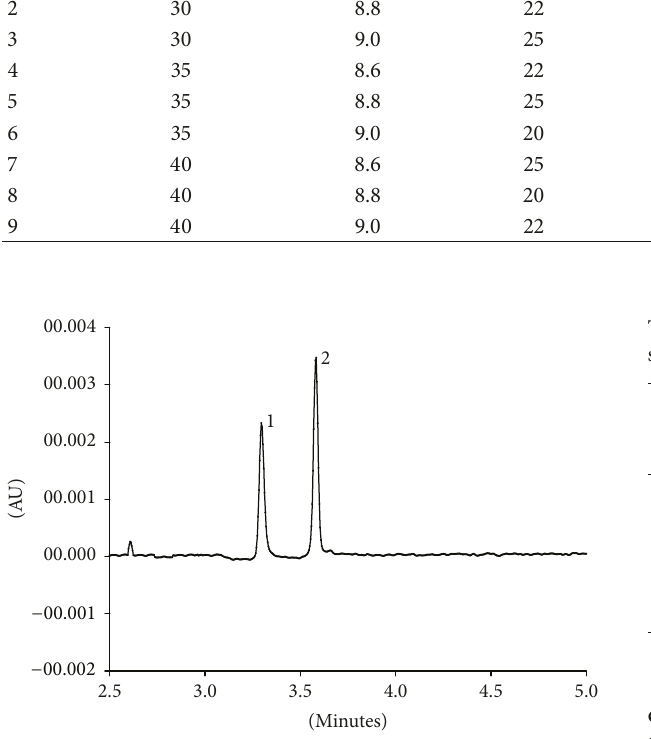
Figure 6: Electrophoretogram of stand solution (20 𝜇 g/mL). Sepa- ration conditions: running buffer, 35 mmol/L H 3 BO 3 -Na 2 B 4 O 7 (pH 8.8); separate voltage, 25 kV; operating temperature, 22 ∘ C; the detec- tion wavelength, 275 nm; injection, 0.5 psi, 4s. Peak identification